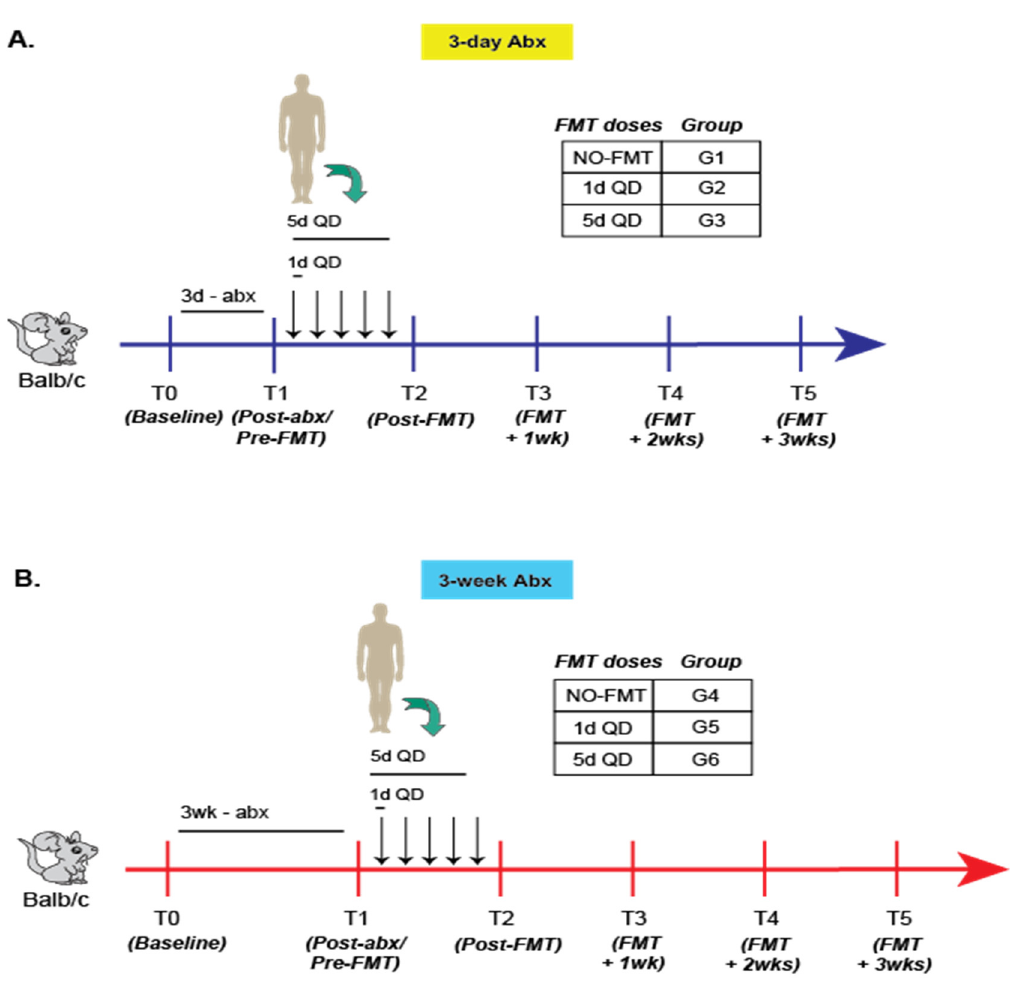
Figure 1. Experimental schema for primary experiment in Balb/c mice. Classification and sampling scheme for mice (n = 5/group) receiving either the ( A ) 3-day or ( B ) 3-week antibiotic regimen. Representative data from two experiments shown.